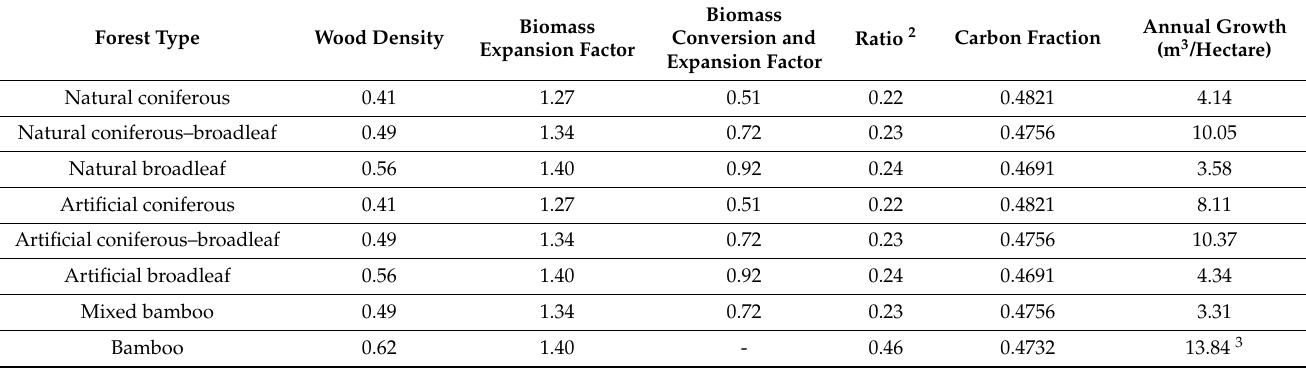
Table 1. Local coefficients for estimating change in forest carbon stock in Taiwan 1